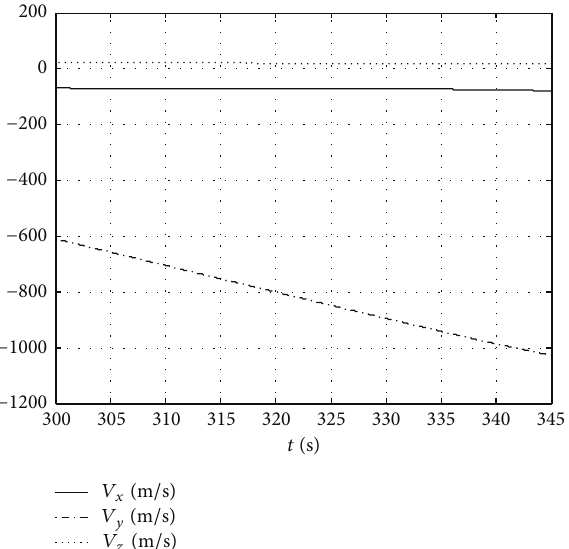
Figure 11: Simulation result of flight